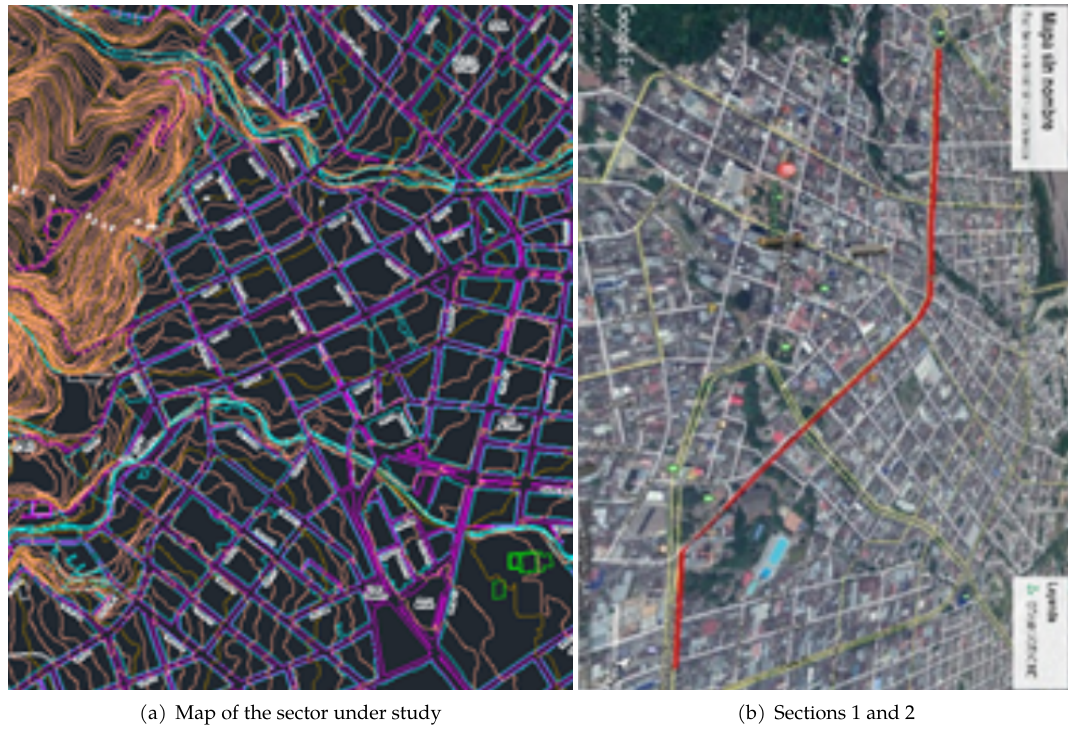
Figure 1: Villavicencio decree 287/2015, and Google Earth,